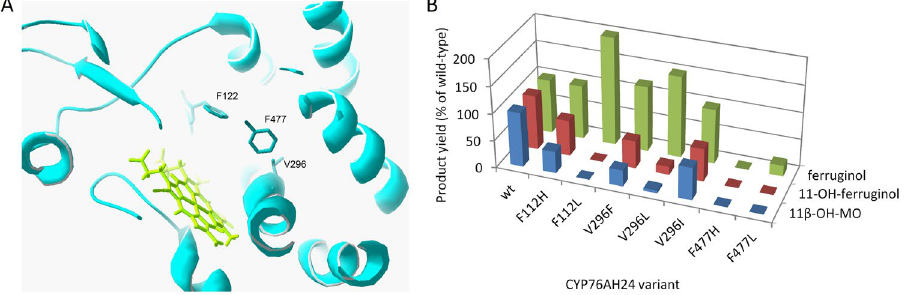
Figure 5. Engineering CYP76AH24 specificity. ( A ) Model of CYP76AH24 showing the residues selected for mutagenesis (F112, V296 and F477). Graphic produced by DeepView (Swiss-PdbViewer). ( B ) Product profile of selected mutants. Products include: ferruginol (green), 11-hydroxy-ferruginol (red) and 11 β -hydroxy- manoyl oxide (blue). Two variants, F112L and V296L, showed substrate selectivity and improved catalytic activity. Product titers for each of the three substrates were normalized based on the corresponding wild-type CYP76AH24 yield listed in Table S1 and considered as